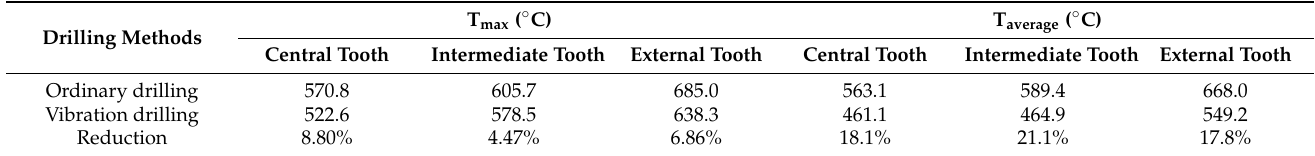
Table 4. Comparison of the temperature of each tooth between ordinary drilling and vibration